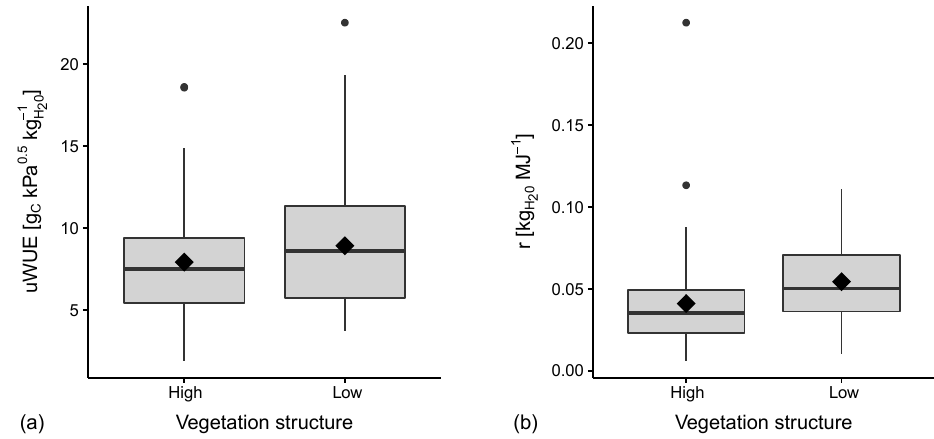
Figure 6. Distribution of the parameter estimates partitioned by type of vegetation structure. For uWUE (a) , a Kolmogorov–Smirnov test yielded no difference in the distribution between the two classes of vegetation structure ( p = 0 . 35). For r (b) , the same test indicated a difference in the distribution between the two classes of vegetation structure ( p = 0 . 003).